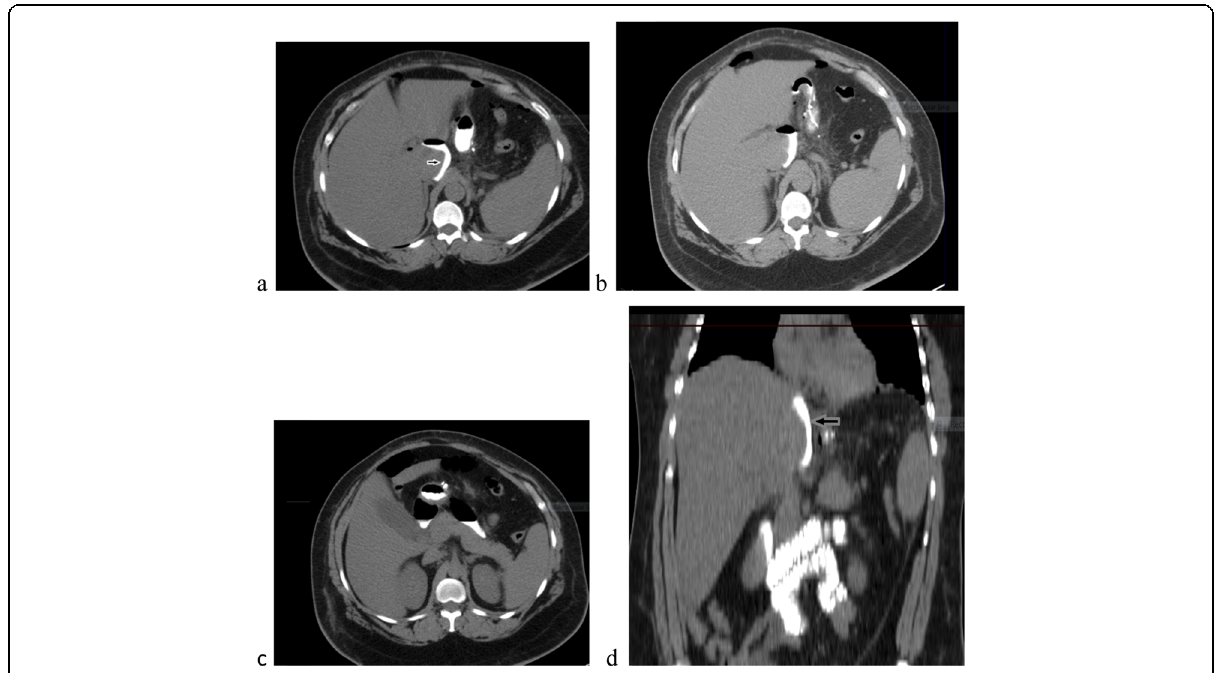
Fig. 10 A forty-five-year-old female patient presented 6 days post-lap. sleeve gastrectomy by abdominal pain and fever and tachycardia. a – c MSCT axial and d coronal reformatted images revealed evidence of leakage of the oral contrast noted; pooling around the caudate lobe with air- fluid level associated with increased fat density noted in the vicinity of the stomach. UGSI shows no abnormality. Diagnosis: gastric leak